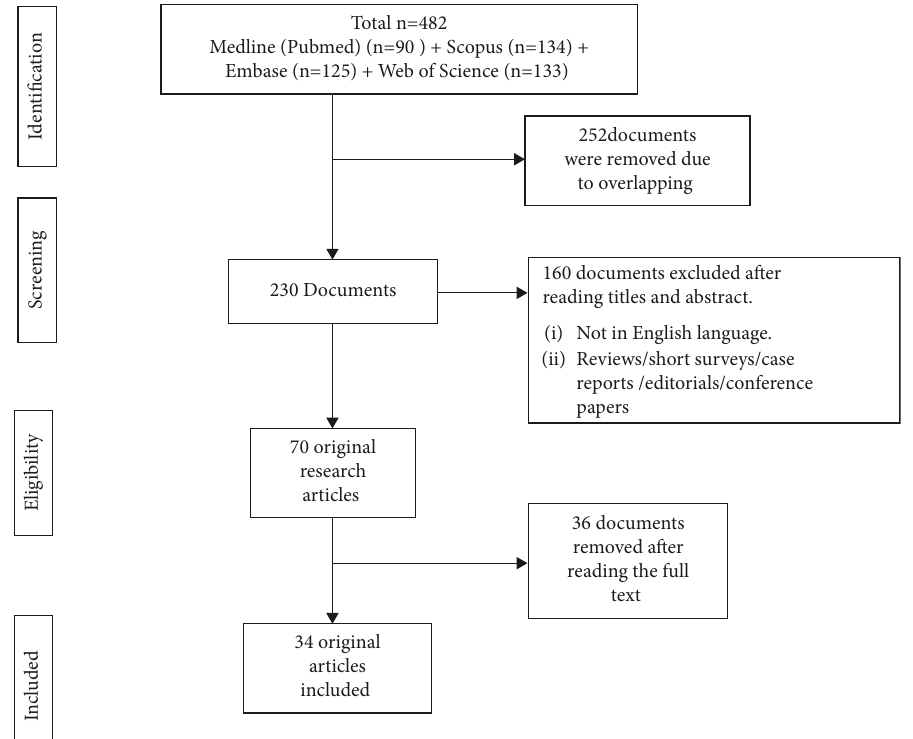
Figure 1: Evidence search for bio-tribocorrosion of dental implants and its toxic implications.